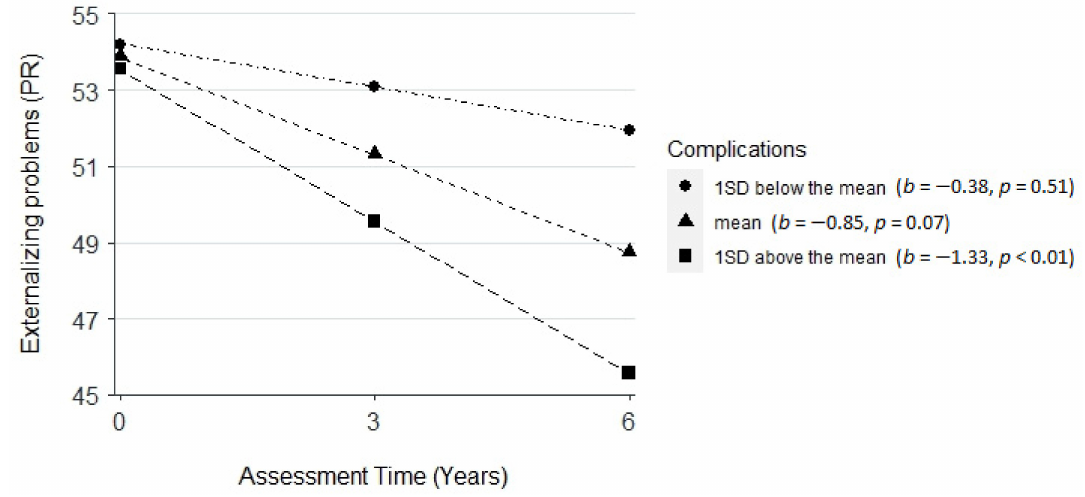
Figure 5. Plot for the interaction effect among assessment time and NF1-related disease complications on externalizing problems (parent-reported,